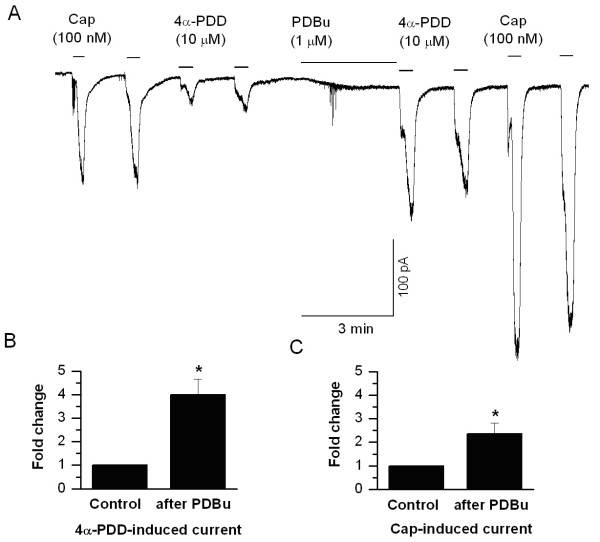
Sensitization of TRPV4 and TRPV1 by PKC in cultured DRG neurons. A. Both capsaicin (100 nM)-induced and 4α-PDD (10 μM)-induced currents are potentiated by a PKC activator, PDBu (1 μM). B, C. Summary graphs showing potentiation of 4α-PDD- and capsaicin-induced current activity by PDBu (1 μM; n = 11). The asterisk (*) represents P < 0.05 as compared to control.